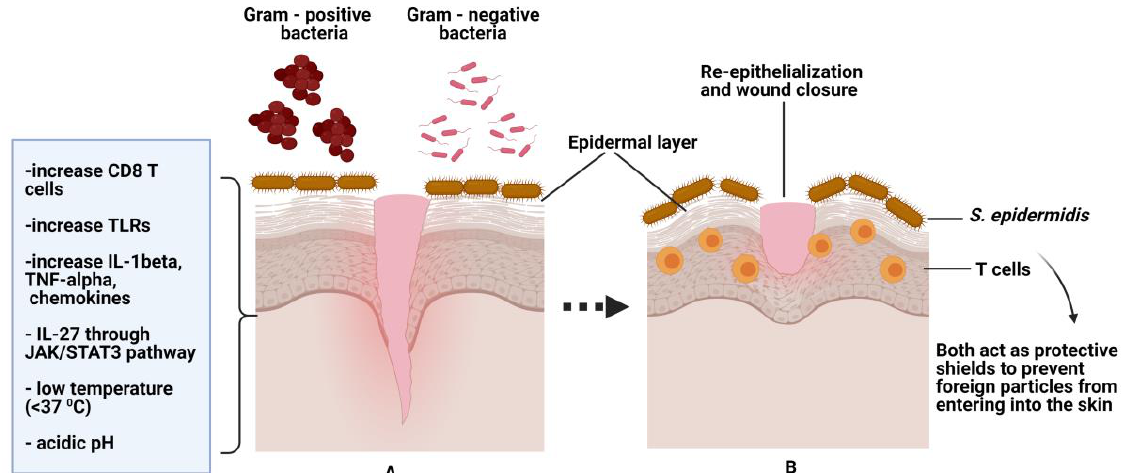
Figure 4. ( A ) shows normal flora/skin microbiome (S. epidermidis) on normal wound healing. The skin is protected from gram-positive /negative bacteria by S. epidermidis . The left corner shows factors that contribute to wound healing and further preventing colonization by skin pathogens. ( B ) shows both S. epidermidis and T cells help in wound closure and act as protective shields against pathogen invasions.